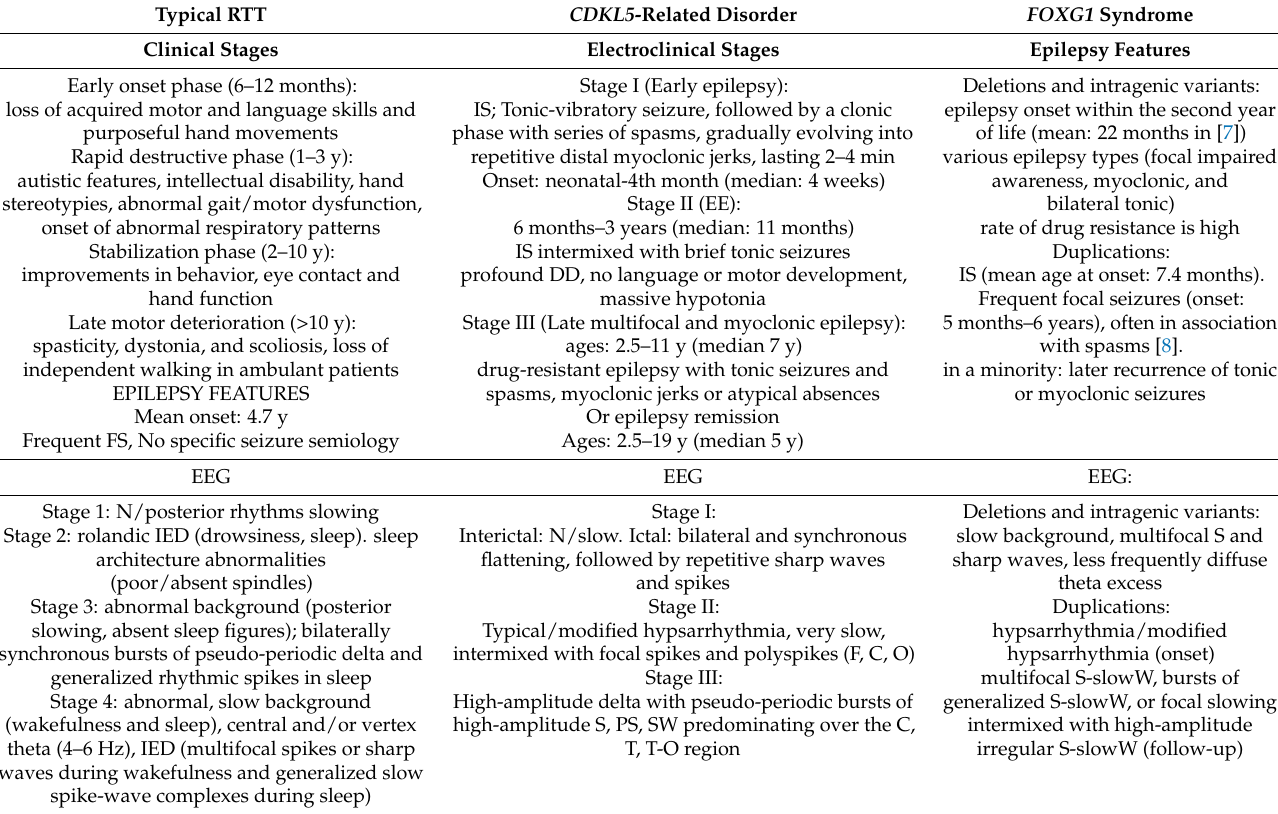
Table 2. Electroclinical characteristics of typical and atypical RTT